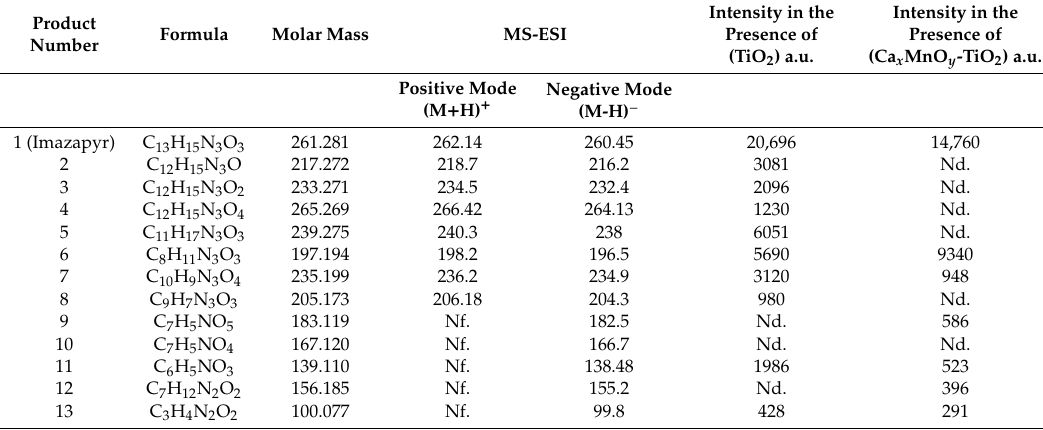
Table 2. Photoproducts of Imazapyr degradation and their intensities identified by the positive and negative modes of